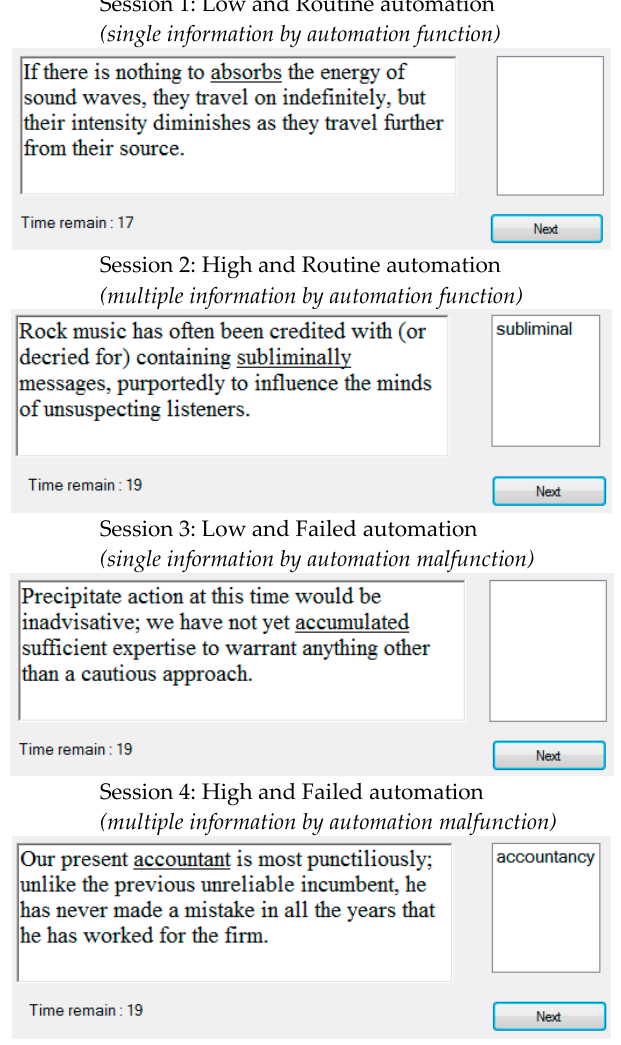
Figure 1. Four sessions of automated proofreading tasks by the combination of Low vs. High and Routine vs. Failed automation. While High automation underlines a gramatically incorrect word along with a possible substitute (multiple information), Low automation provide only a underlined word (single information). While a correct word is underlined and an incorrect substitute is presented in Failed automation, (malfunction of automation), an incorrect word is underlined and a correct substitute is provided in Routine automation.